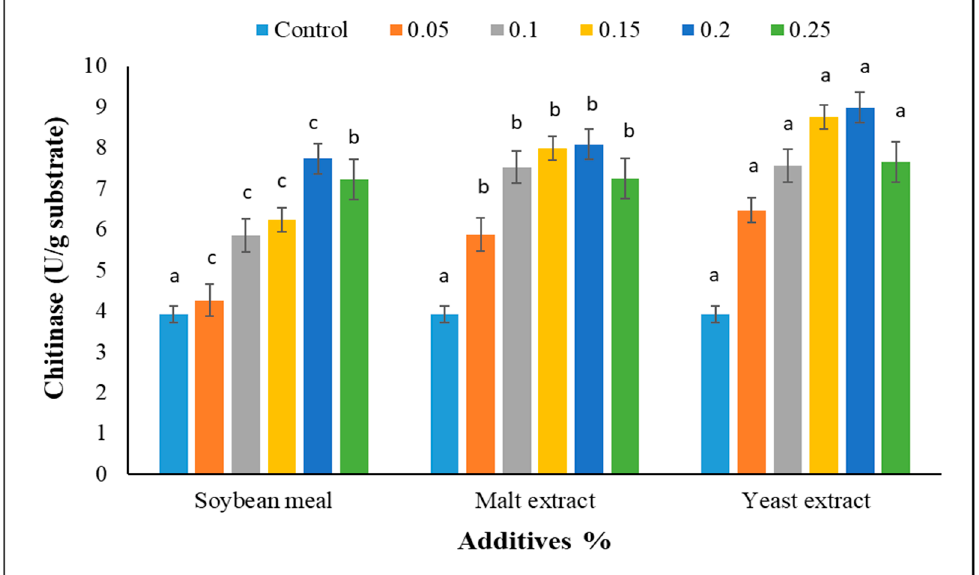
Figure 4. Effect of additives concentrations on the production of chitinase on SSF by T. funiculosus strain CBS 129594. The values are the means of three replicates with standard deviation (±SD). Mean values in each bar followed by a different lower-case letter are significantly different according to Duncan’s multiple range tests at p ≤ 0.05.